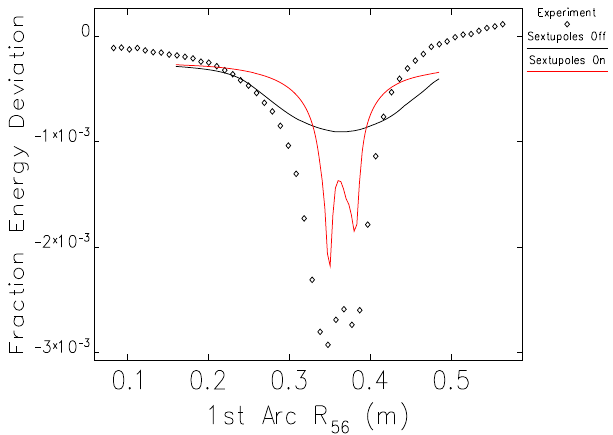
FIG. 3. Energy loss measurement and simulation due to CSR as a function of R A 1 56 for rising rf acceleration.